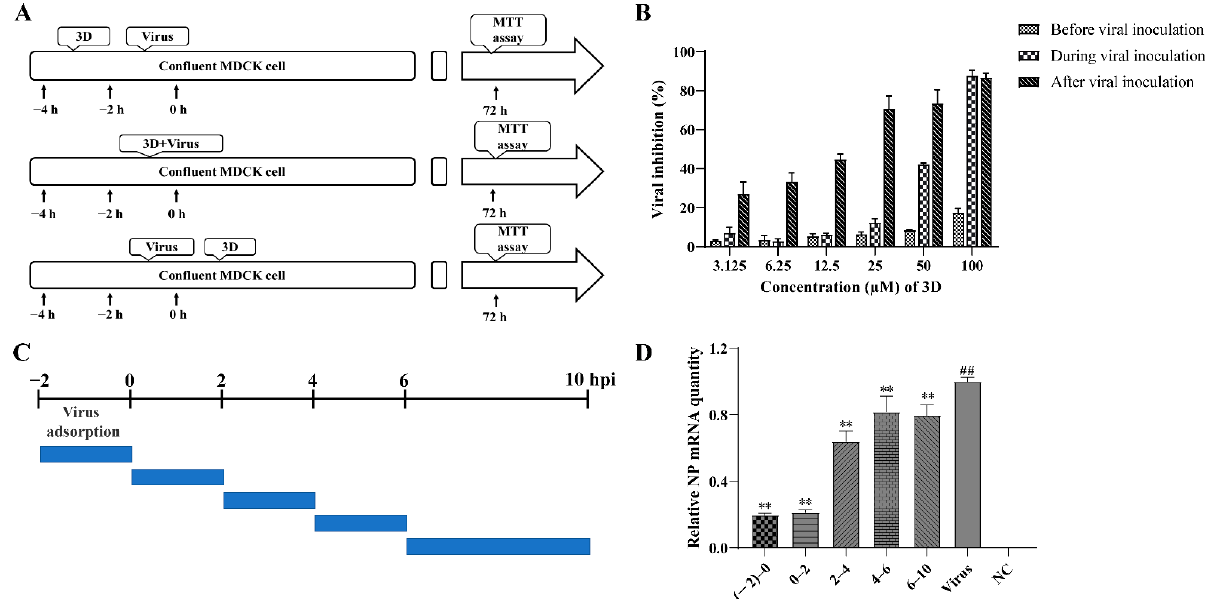
Figure 3. Inhibition of influenza A virus replication by 3D. ( A , B ) MDCK cells were treated with various concentrations of 3D before viral adsorption for 2 h, during viral adsorption for 2 h and after viral adsorption. The inhibition rates were determined by MTT assay at 72 h post-infection. ( C , D ) The infected MDCK cells were treated with 3D at indicated time intervals. At 10 h post-infection, cells were harvested and the expression level of viral NP mRNA was analyzed by qRT-PCR. The data are shown as the mean ± SD. ( ## p < 0.01 compared with the normal control; ** p < 0.01 compared with the virus control).